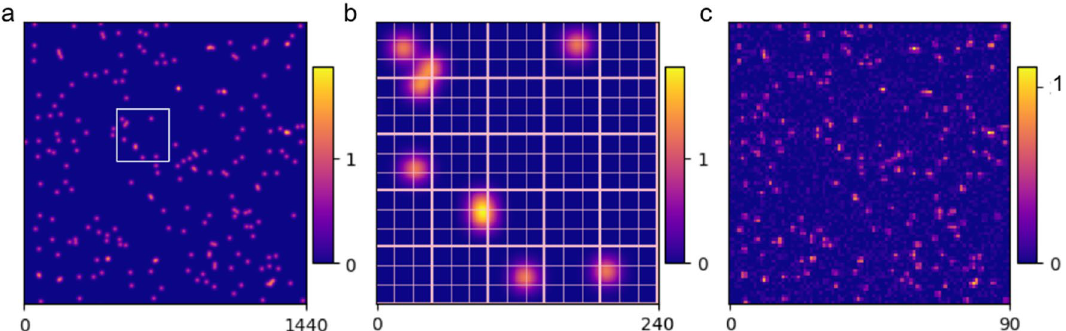
Figure 1. CCD charge sharing model of speckle patterns. ( a ) Sparse distribution of weakly scattered photons 3 pixels/speckle basis, generated via the negative binomial distribution (Eq. 1) within the range on a 3 × 0.025, 0.25 k photons/speckle. The selected contrast is 0.7. The map is high-resolution since every pixel is = [ ] 16 to obtain a sub-pixel placement of Gaussian shaped charge clouds (FWHM 1 pixel). sub-divided by 16 × ∼ 5 speckle area ( b ) Enlarged portion of the high resolution photon map (white square box in a ), displaying a 5 × 3 pixels (light lines boundaries). Photons can sprawl over (bold lines boundaries), each speckle containing 3 × both pixel and speckle boundaries. ( c ) Final ccd image of the speckle pattern obtained after binning the high 0.05 photon). A single 90 grid and adding readout noise ( σ resolution photon map ( a ) to a coarser 90 N = × photon readout is 350